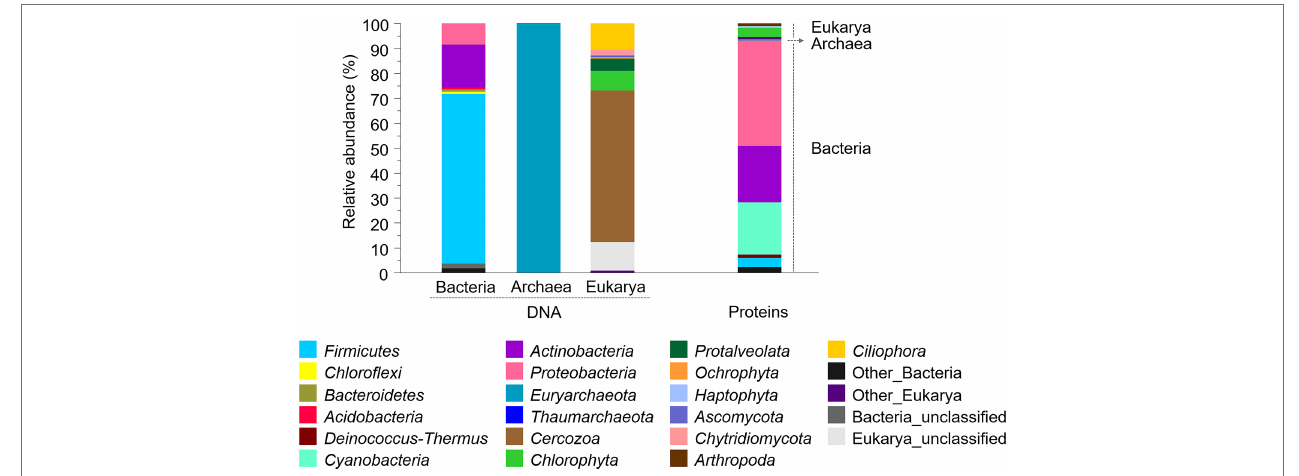
FIGURE 5 | Composition and relative abundances of bacterial, archaeal, and eukaryotic phyla in the desiccated microbial mat obtained with SSU rRNA genes (left) and metaproteomics (right) analyses. For proteins, the relative abundance was calculated based on a normalized spectral abundance factor (NSAF) annotated per cent. Phyla with relative abundances below 0.5% were comprised within “Other”